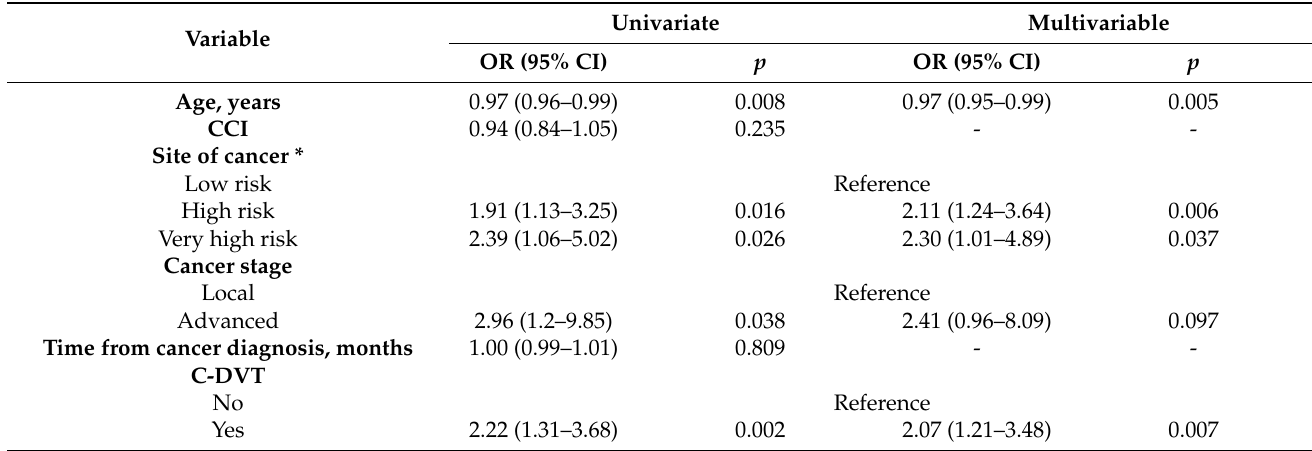
Table 3. Univariate and multivariable logistic regression analyses of clinical factors associated with venous thromboembolism recurrence within 6 months in cancer patients with unsuspected pulmonary embolism ( n =